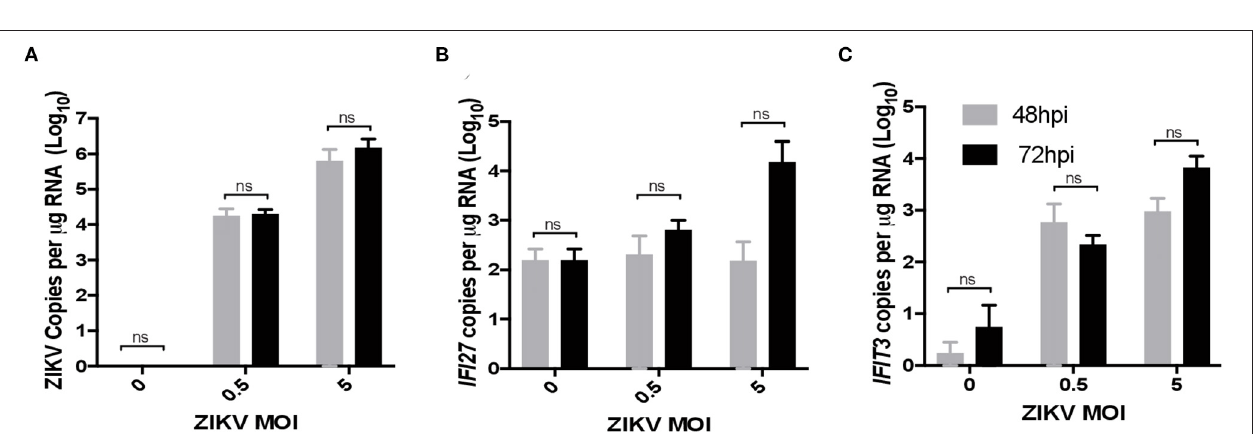
FIGURE 6 | ZIKV infection in vitro induces IFI27 expression in rhesus macaque decidua and villous. CD14 + cells were isolated from the decidua and villous of uninfected control rhesus macaque and infected with ZIKV (MOIs = 0.5 and 5 FFU/cells) at 72hpi supernatants were collected and analyzed by qRT-PCR for expression of (A) ZIKV (B) IFI27 (C) IFIT3 using species specific primers. Student’s t -test was used to determine statistical significance.